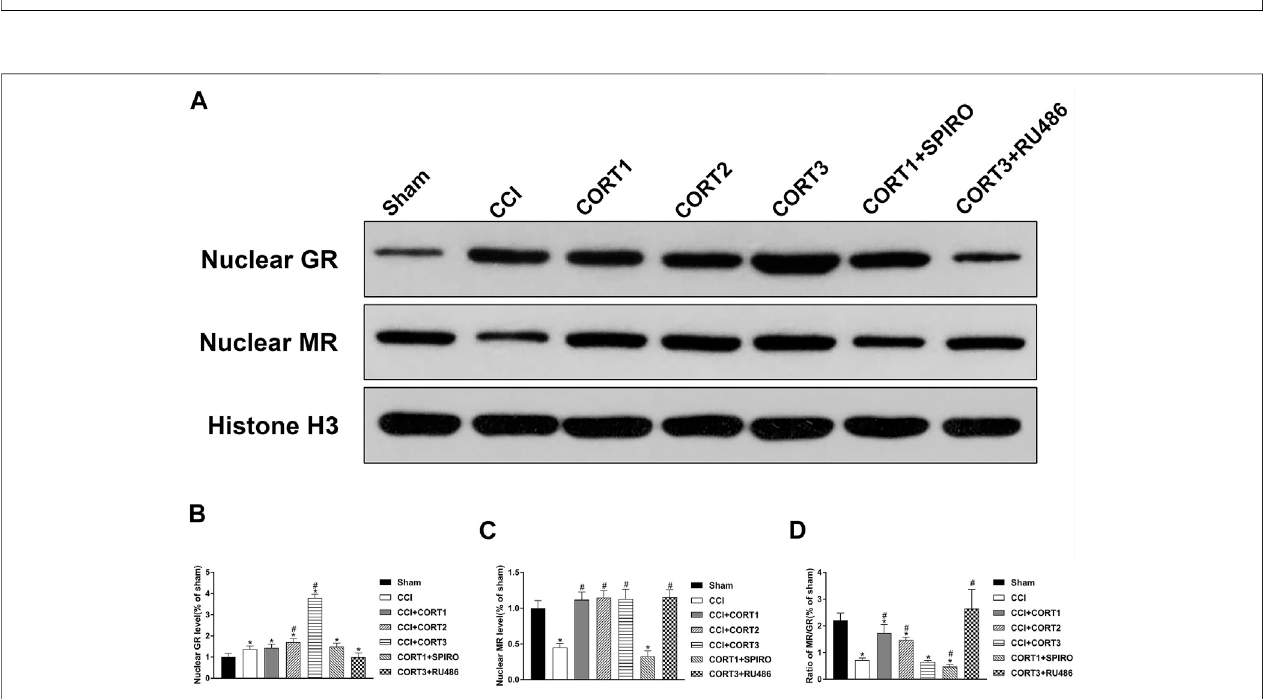
FIGURE 5 | Dose-dependent effects of CORT treatments on the activation of MR and GR. (A) Representative western blot images of nuclear MR and GR. (B – D) Quanti fi cationofnuclearMR,nuclearGR,andtheratioofMR/GR.TherelativebanddensitywasmeasuredwithImageJsoftware(version1.49)andnormalizedtothatof histone H3, and the concentration percentage compared to that of sham controls was calculated for each sample. * p < 0.05 compared to the sham group; # p ˂ 0.05 compared to the CCI control group. The data are presented as the means ± SDs of eight animals per group.